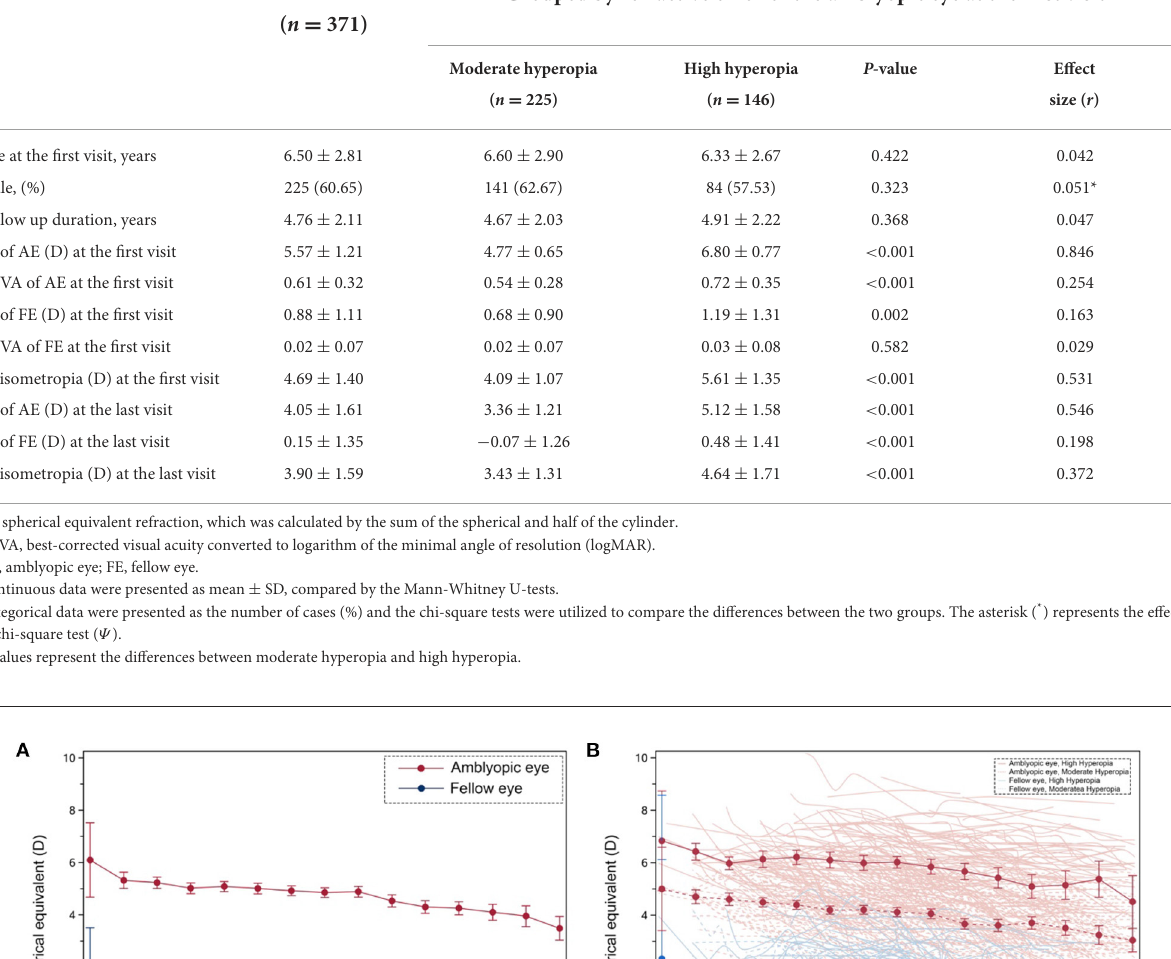
TABLE 1 Demographic characteristics of the